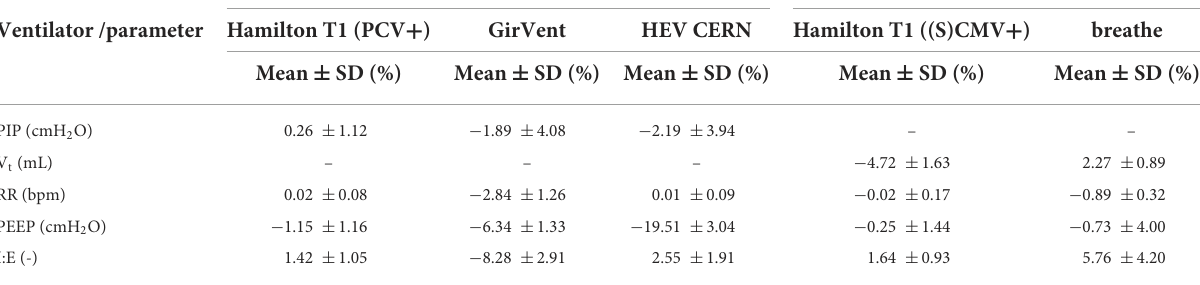
TABLE 3 Mean and standard deviation (SD) of the relative error over all experiments and respiratory cycles for RR, PEEP, I:E, and PIP or Vt for the pressure-controlled and volume-controlled ventilators,